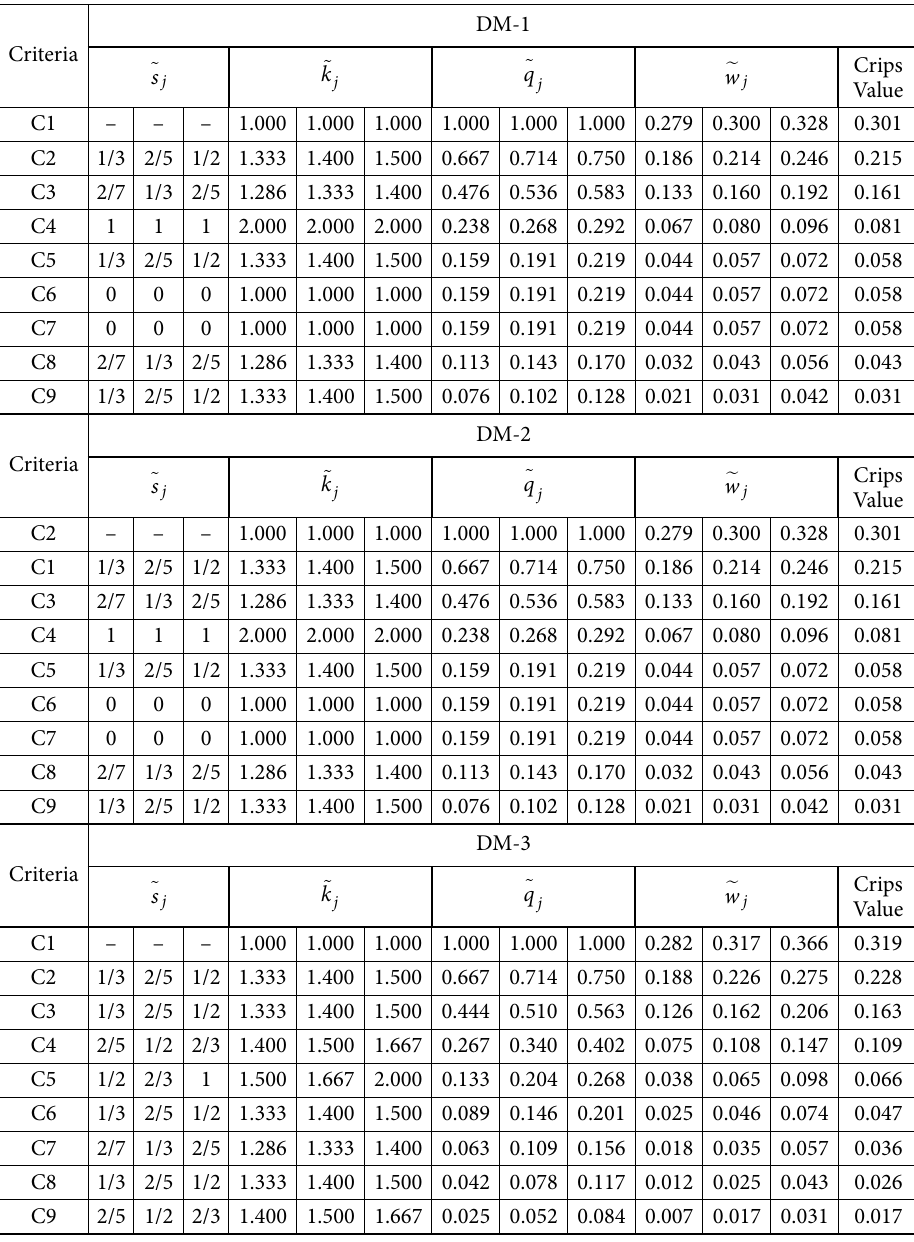
Table 5. The weights of criteria were calculated by using the IMF SWARA technique